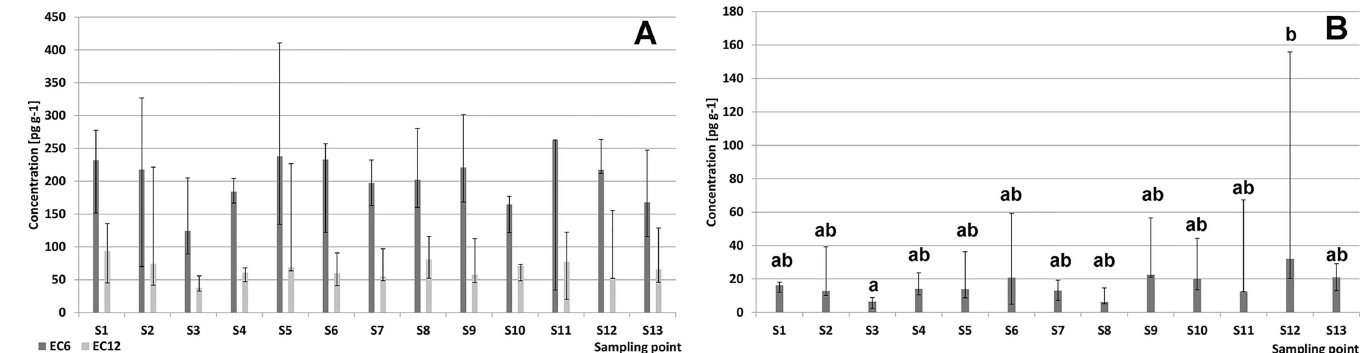
Fig 6. Averageconcentrations (medians, 25/75 percentiles) for 13 sampling locations. A (left): six indicatorCBs (EC6, dark bars) and twelve dioxin- like CBs (EC12, light bars). B (right): PBDEs. Significantly different groups are marked with letters a, b, or ab ( α = 0.05).